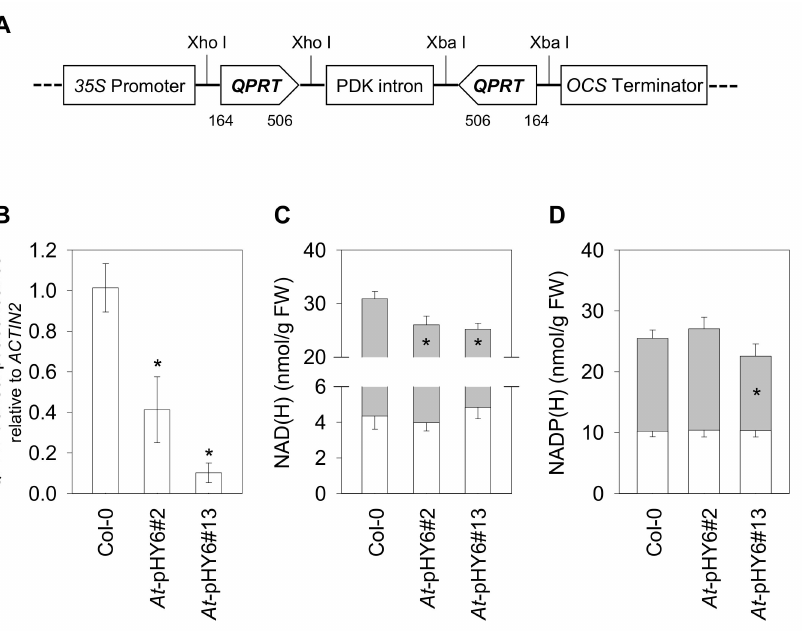
Figure 2. Generation of QPRT RNAi lines and determination of pyridine nucleotides contents in Arabidopsis. ( A ) The RNAi construct pHY6 contained a 35S promoter, a sense fragment of QPRT cDNA from 164 to 506, the PDK intron, the QPRT fragment in antisense orientation, and an OCS terminator. ( B ) QPRT mRNA levels analyzed by qRT-PCR. Contents of NAD(H) ( C ) and NADP(H) ( D ) were quantified. White bars, reduced forms; black bars, oxidized forms. Data are means ± SE of three biological replicates. Asterisk indicates difference relative to Col-0 for each form at * p <